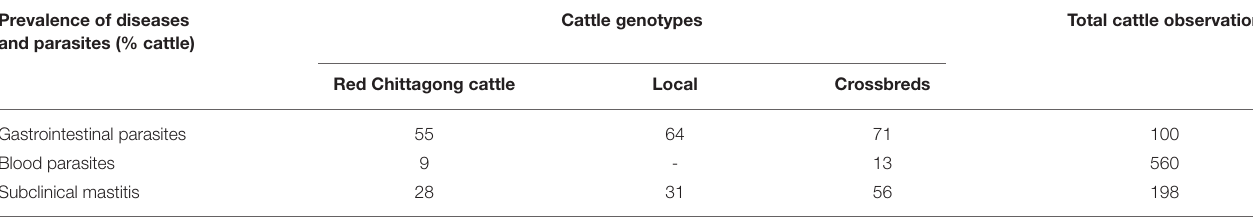
Cattle genotypes Total cattle